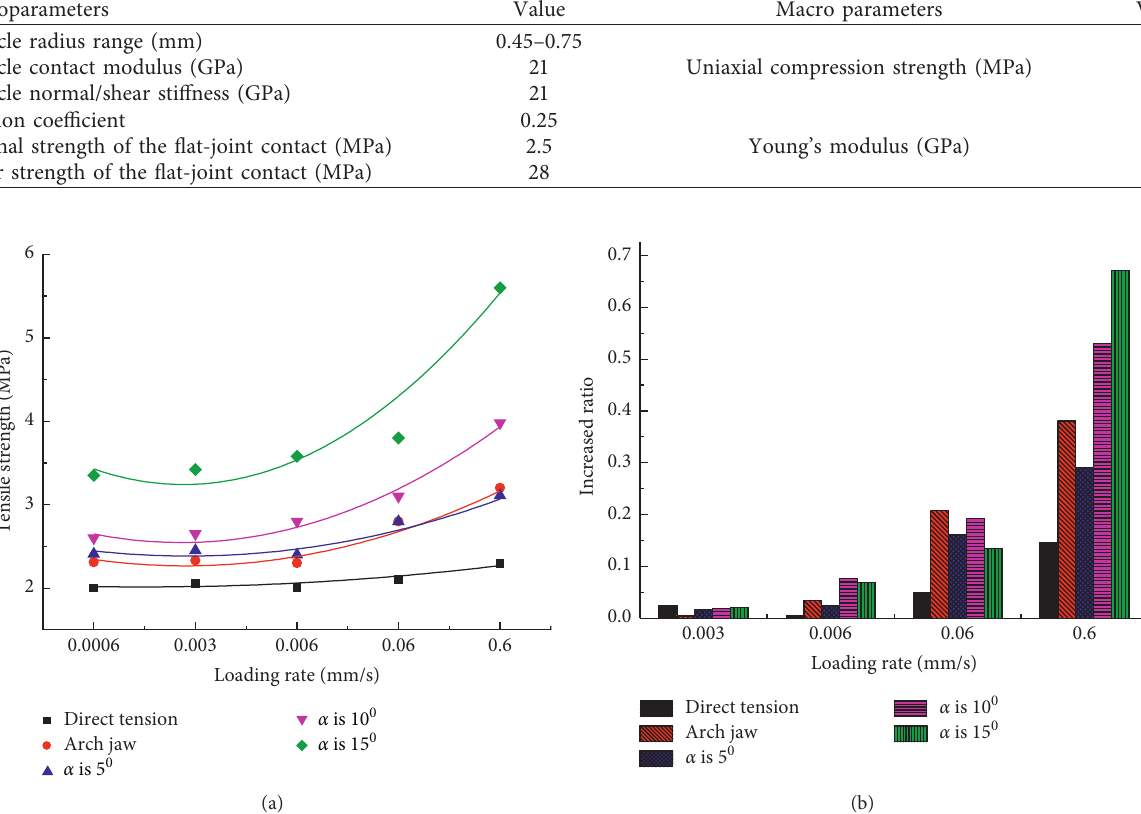
Figure 10: Numerical results: (a) calculated tensile strength using equations (1)–(3); (b) increase ratio using equation (5).